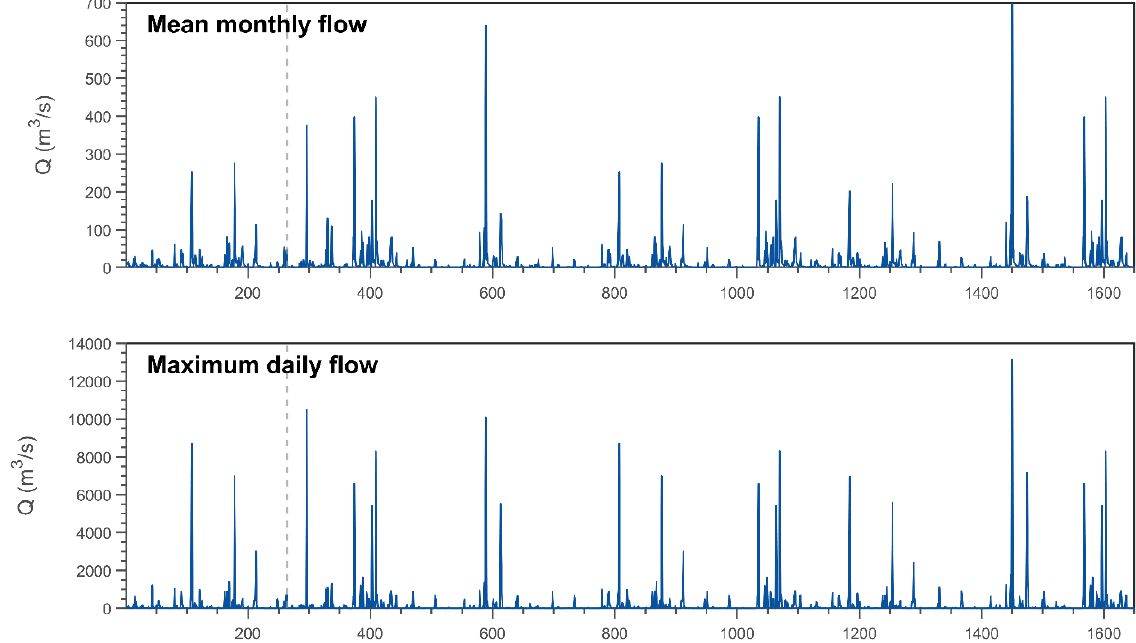
Figure A5. Mean monthly (top) and maximum daily (bottom) synthetic inflow hydrographs of additional scenario #3. The dashed line indicates the construction of the Wivenhoe Dam.